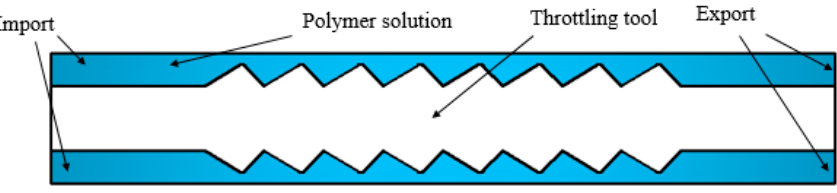
Figure 2. Two ‐ dimensional representation of the partial pressure tool model.